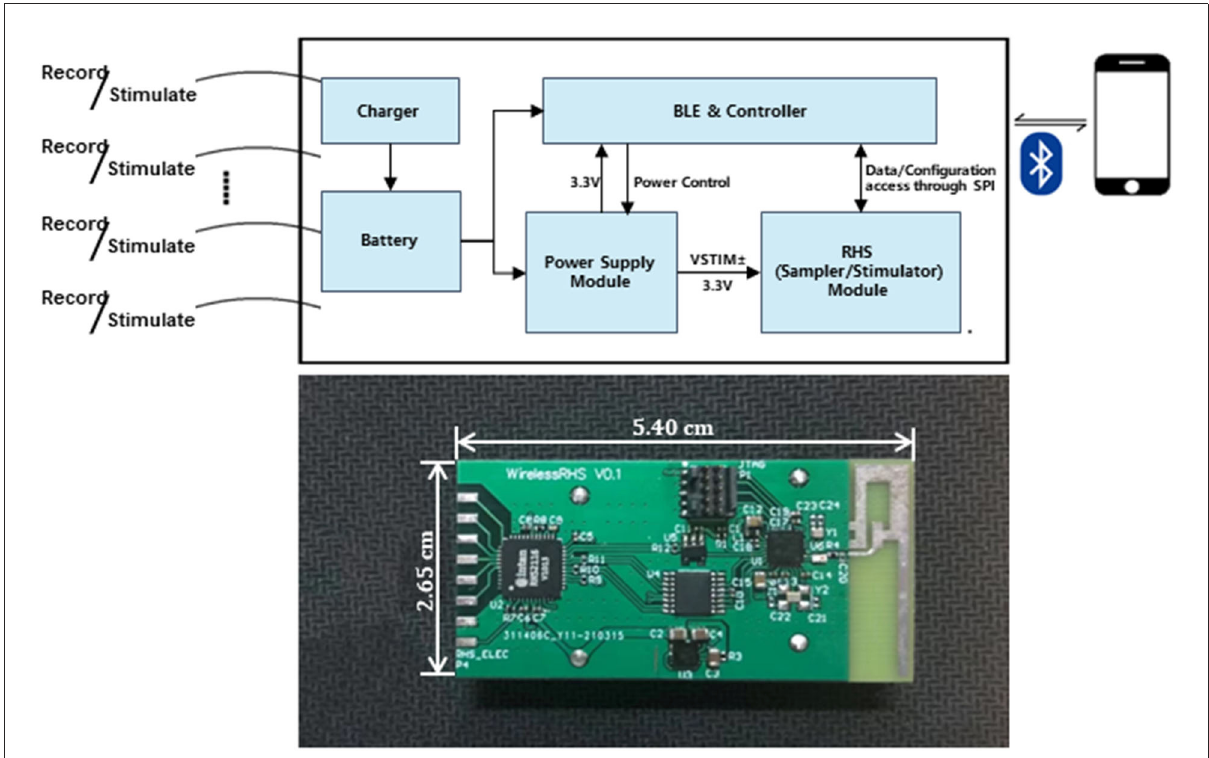
FIGURE1 Implant device system architecture and block diagram of the IC and diagram of the developed system.